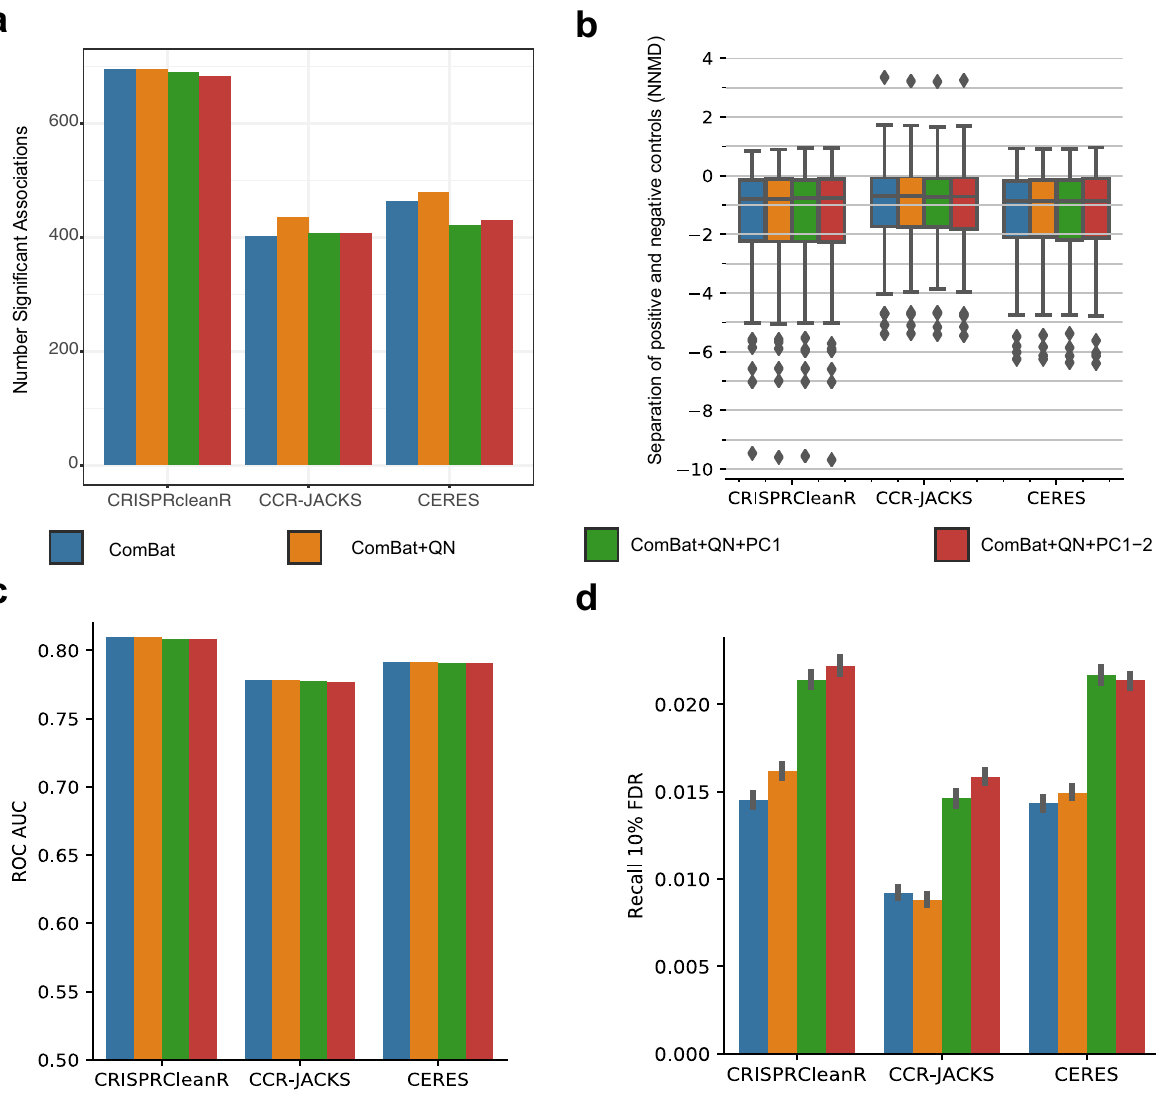
Fig. 5 Use case Biomarkers and functional relationships. a For each tissue pairs of Cancer Functional Events (CFEs) and dependencies were tested using a two-sided t- test for signi fi cant associations between the gene dependency and the absence/presence of a biomarker (CFE). The bar chart shows the total number of signi fi cant associations at 5% false-discovery rate (FDR) across tissue types for each of the integrated datasets. Results are shown across different pre-processing methods, CRISPRcleanR, CRISPRcleanR with JACKS (CCR-JACKS) and CERES (in different plots) and different batch correction pipelines. The different batch correction pipelines are ComBat only (ComBat in blue), ComBat followed by quantile normalization (ComBat + QN, orange), and ComBat + QN with either the fi rst PC removed (ComBat + QN + PC1, shown in green) or fi rst two PCs removed (ComBat + QN + PC1-2, red). b The per- oncogene null-normalized mean difference (NNMD) between cell lines with and without an indicated oncogenic gain-of-function indication (more negative is better). The boxplot shows the interquartile range in the box with the median as a horizontal line. Whiskers extend to 1.5 times the interquartile range and outlier points outside this range plotted. c For all identi fi ed oncogenes collectively, the receiver-operator characteristic (ROC) area under curve (AUC) between oncogene scores in cell lines where they have an indicated gain-of-function mutation and cell lines where they do not. d . For each dataset, the number of known gene-gene relationships recovered at 10% FDR. The number of relationships tested varied between N = 346,114 and N = 346,744. The error bars show the 95% con fi dence intervals generated from 100 bootstrap